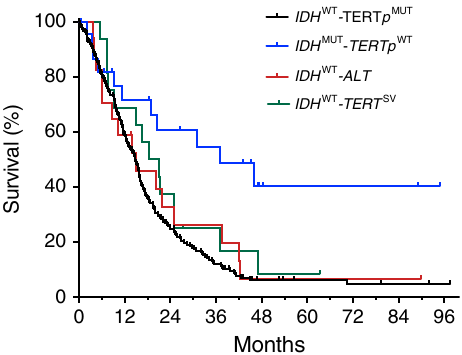
Fig. 3 New genetic subgroups of GBM display distinct survival